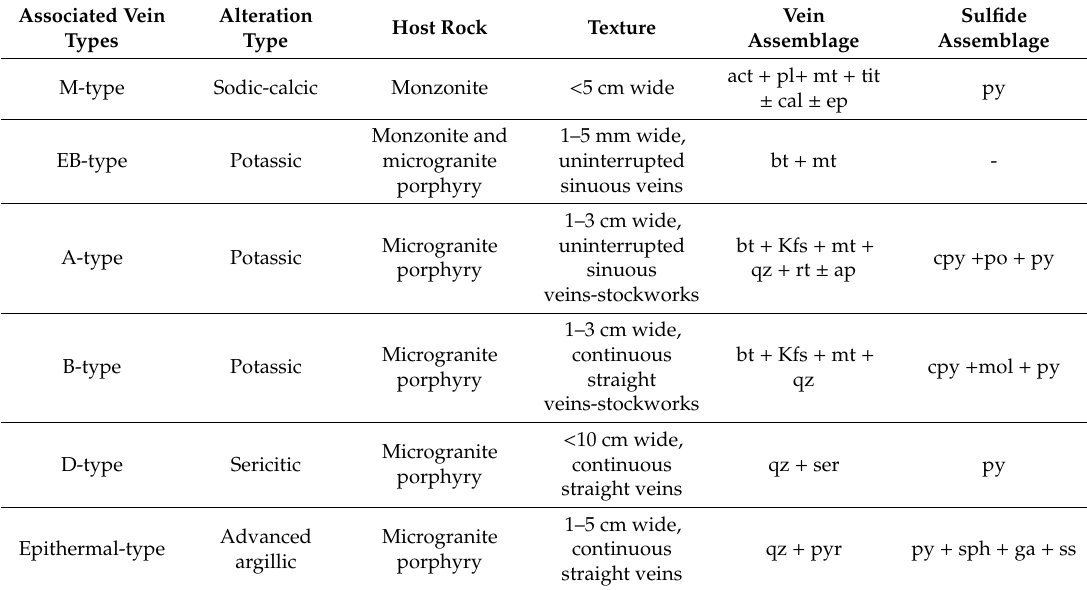
Table 1. Characteristics of veins in the alteration zones at Maronia. act: actinolite; ap: apatite; bt: